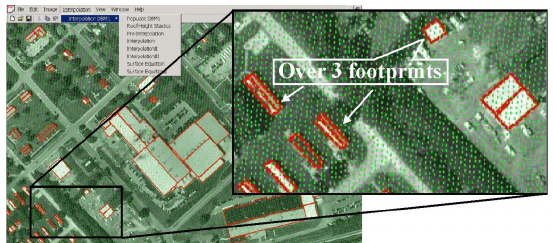
Figure 7: Co-registration of aerial imagery and LiDAR point cloud data (Courtesy of Zhou et al. (2004)) Step 2: Extraction of initial edges of houses from LiDAR point